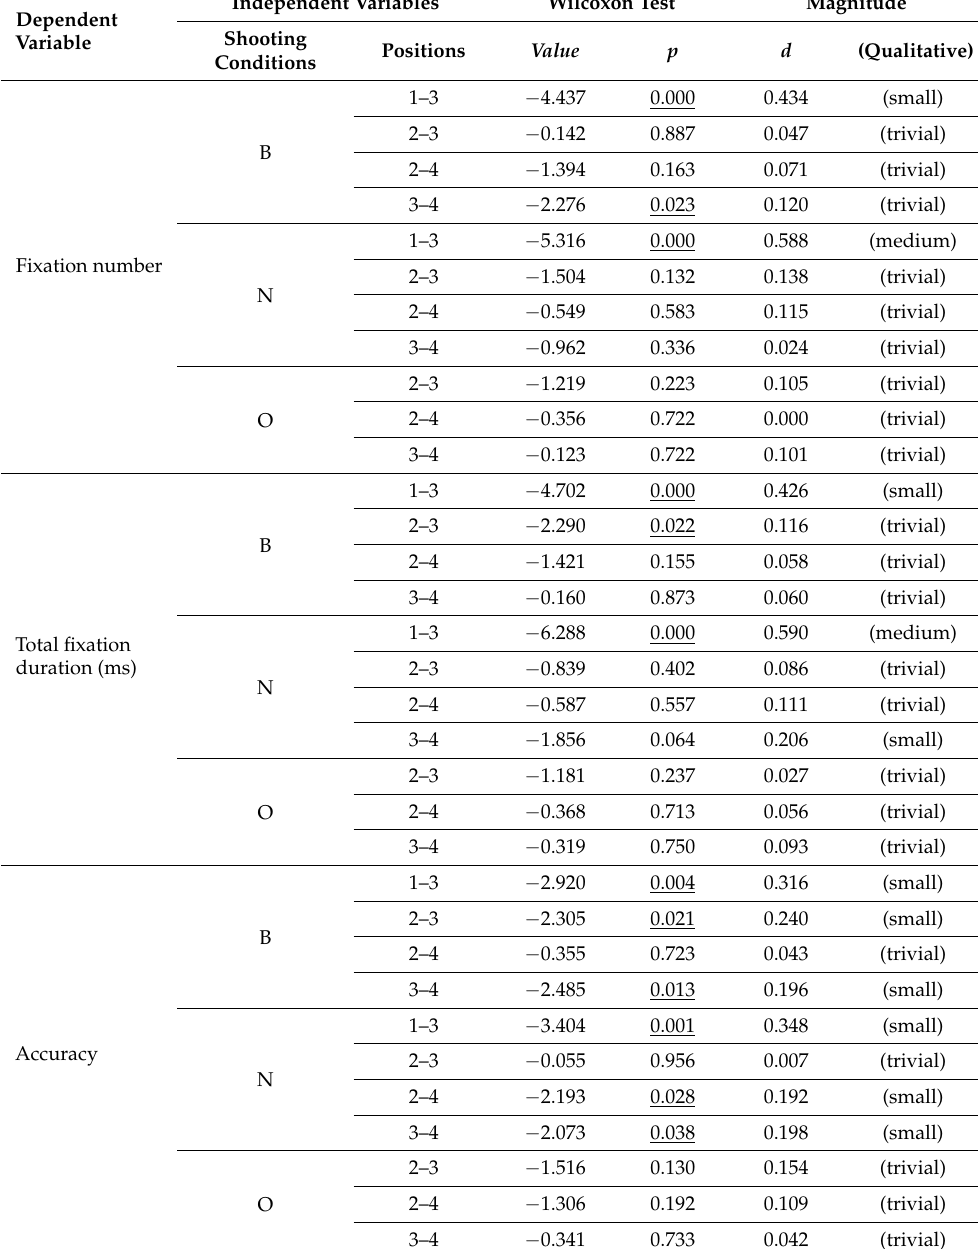
Table 4. Results of the Wilcoxon test and effect sizes [41] for all variables with statistical significance (number of fixations and total time of fixations) for the sample (n =